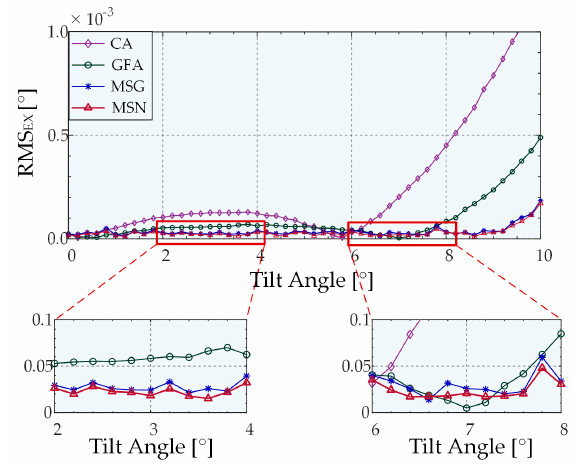
Figure 7. Peak-extraction errors of different algorithms based on simulations.